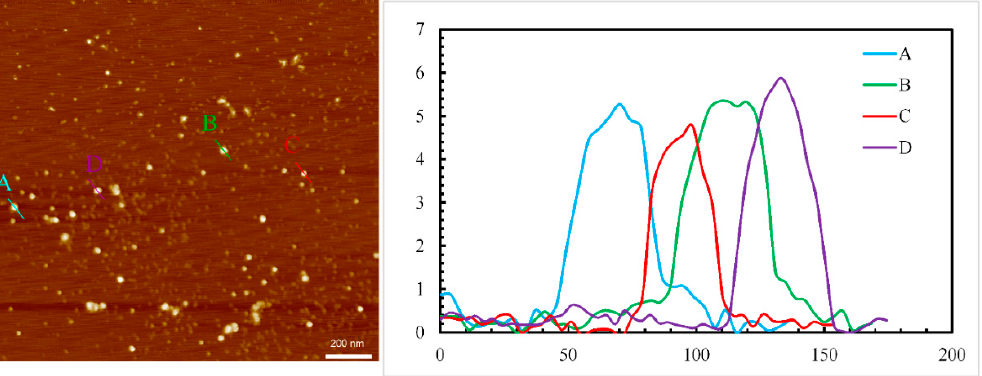
Figure 7. AFM image showing sparsely clustered or aggregated Polymer 2 CUP particles (left) and the height (nm—y axis) and width (nm—x axis) of the profile of the analyzed particles